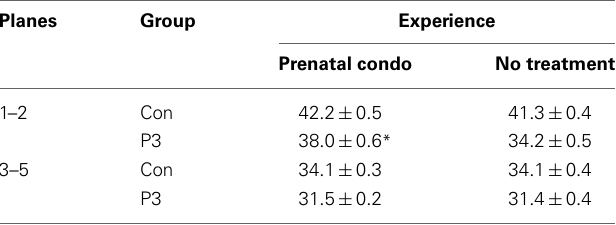
Table 3 | Summary of cortical thickness at anterior and